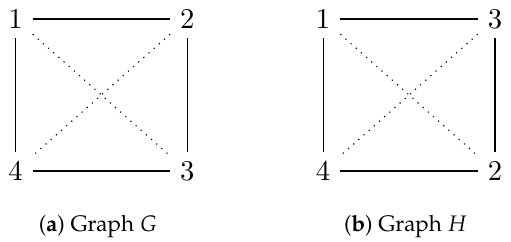
Figure 4. Isomorphic graphs G , H and complements indicated by dashed